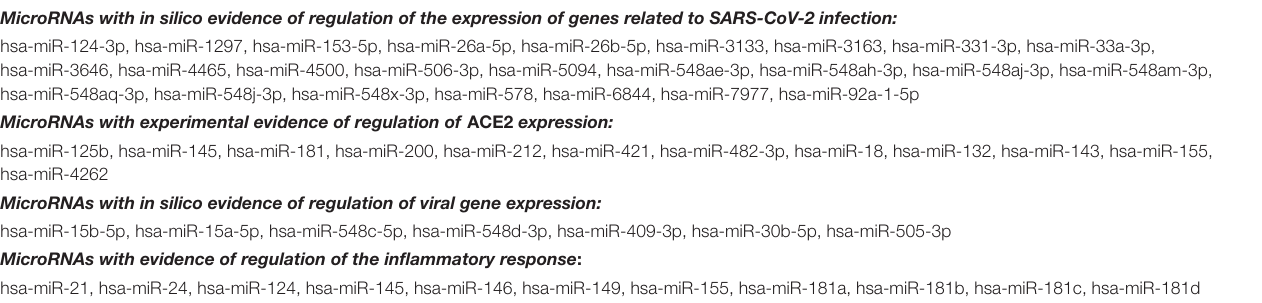
TABLE 3 | MicroRNAs possibly relevant in COVID-19, according to their type of evidence. MicroRNAs with in silico evidence of regulation of the expression of genes related to SARS-CoV-2 infection: hsa-miR-124-3p, hsa-miR-1297, hsa-miR-153-5p, hsa-miR-26a-5p, hsa-miR-26b-5p, hsa-miR-3133, hsa-miR-3163, hsa-miR-331-3p, hsa-miR-33a-3p, hsa-miR-3646, hsa-miR-4465, hsa-miR-4500, hsa-miR-506-3p, hsa-miR-5094, hsa-miR-548ae-3p, hsa-miR-548ah-3p, hsa-miR-548aj-3p, hsa-miR-548am-3p, hsa-miR-548aq-3p, hsa-miR-548j-3p, hsa-miR-548x-3p, hsa-miR-578, hsa-miR-6844, hsa-miR-7977, hsa-miR-92a-1-5p MicroRNAs with experimental evidence of regulation of ACE2 expression: hsa-miR-125b, hsa-miR-145, hsa-miR-181, hsa-miR-200, hsa-miR-212, hsa-miR-421, hsa-miR-482-3p, hsa-miR-18, hsa-miR-132, hsa-miR-143, hsa-miR-155,